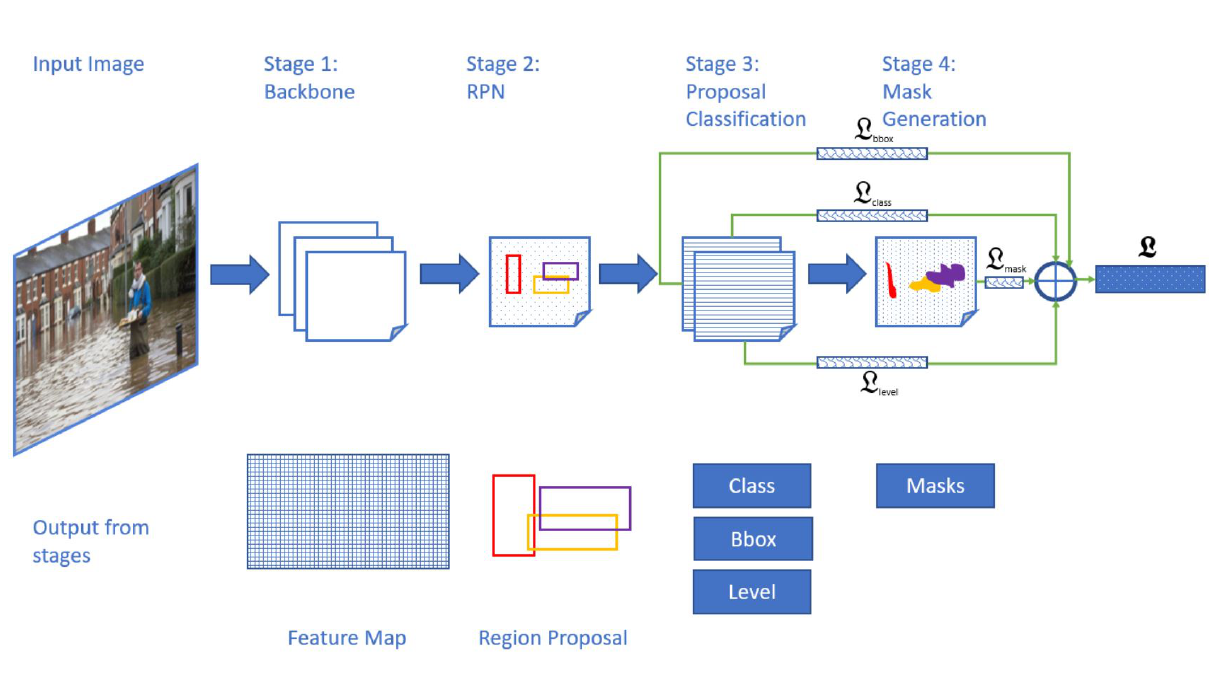
Figure 1. Shows the overall architecture and respective output from each